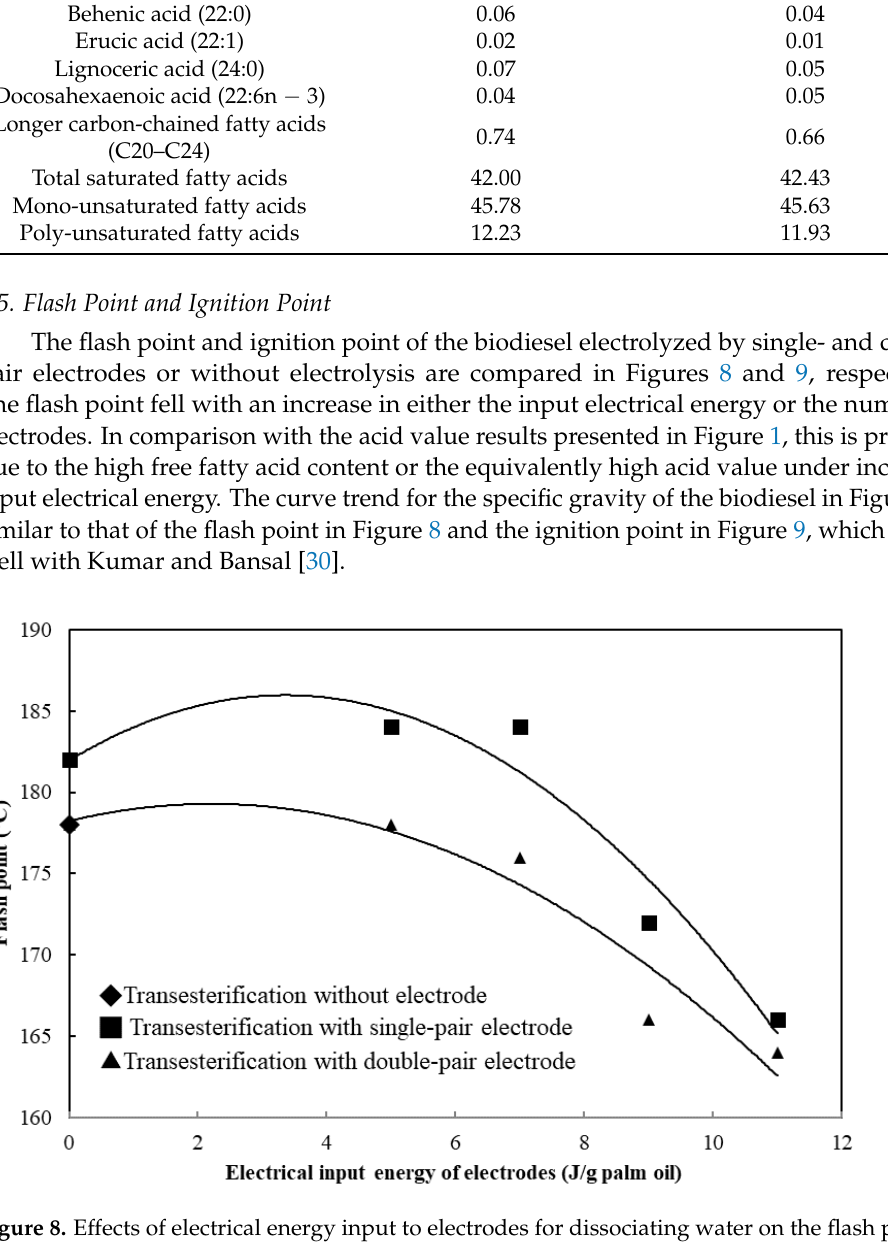
Figure 9. Effects of electrical energy input to electrodes for dissociating water on the ignition point of biodiesel product. As seen from Table 1, a larger amount of longer carbon-chained fatty acids in the range between C20 and to C24 was produced after application of the single-pair electrodes to remove water from the reactant mixture during the transesterification reaction. Hence, a higher flash point and ignition point appeared for the biodiesel electrolyzed by the single-pair electrodes, as seen in Figures 8 and 9. 3.6. Distillation Temperature Figure 10 shows the distribution curve of distillation temperatures, which is also termed the ASTM D86 distillation temperature curve of the biodiesels electrolyzed by single- or double-pair electrodes. The effects of different electrical energy inputs, including 0, 5, and 11 J/(g palm oil), on the distillation temperature were observed. The distillation temperatures of the biodiesel electrolyzed by the single-pair electrodes are shown in Figure 10a. The highest distillation temperature (362 °C ) appeared after the reactant mixture for the transesterification reaction was electrolyzed with 11 J/(g palm oil) electrical energy input through the single-pair electrodes. In comparison with the results for specific gravity in Figure 7, the lowest specific gravity was observed for the biodiesel electrolyzed with input electrical energy of 11 J/(g palm oil). This is probably because the